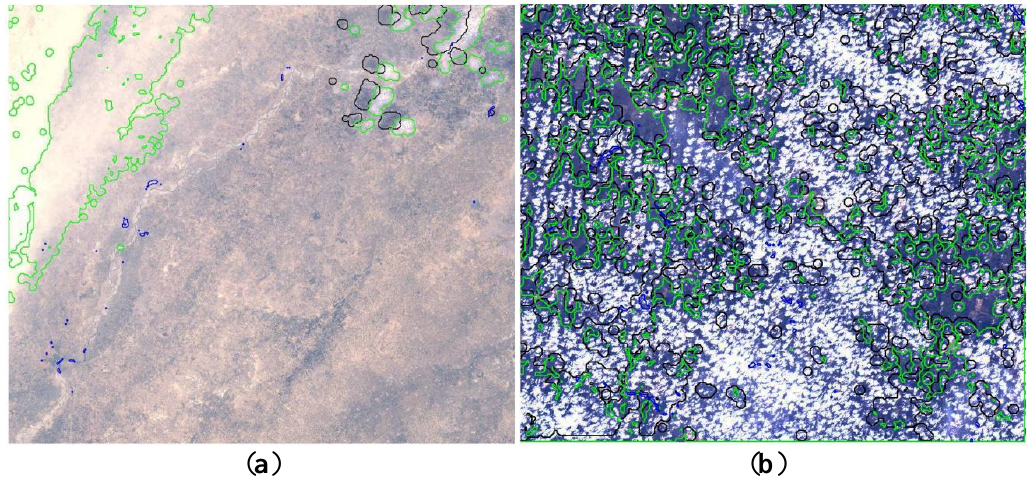
Figure 4. Cloud detection ( a ) over the Pakistan site (May 25, 2013, top left: 31.74°N–72.46°E, low right: 31.52°N–72.70°E) with haze and clouds over desert and ( b ) over the Ukrainian site (November 10, 2013, top left: 50.25° N–29.80° E, low right: 49.69° N–30.71°E) with a large number of cumulus clouds. Clouds are circled in green and shadows in black.